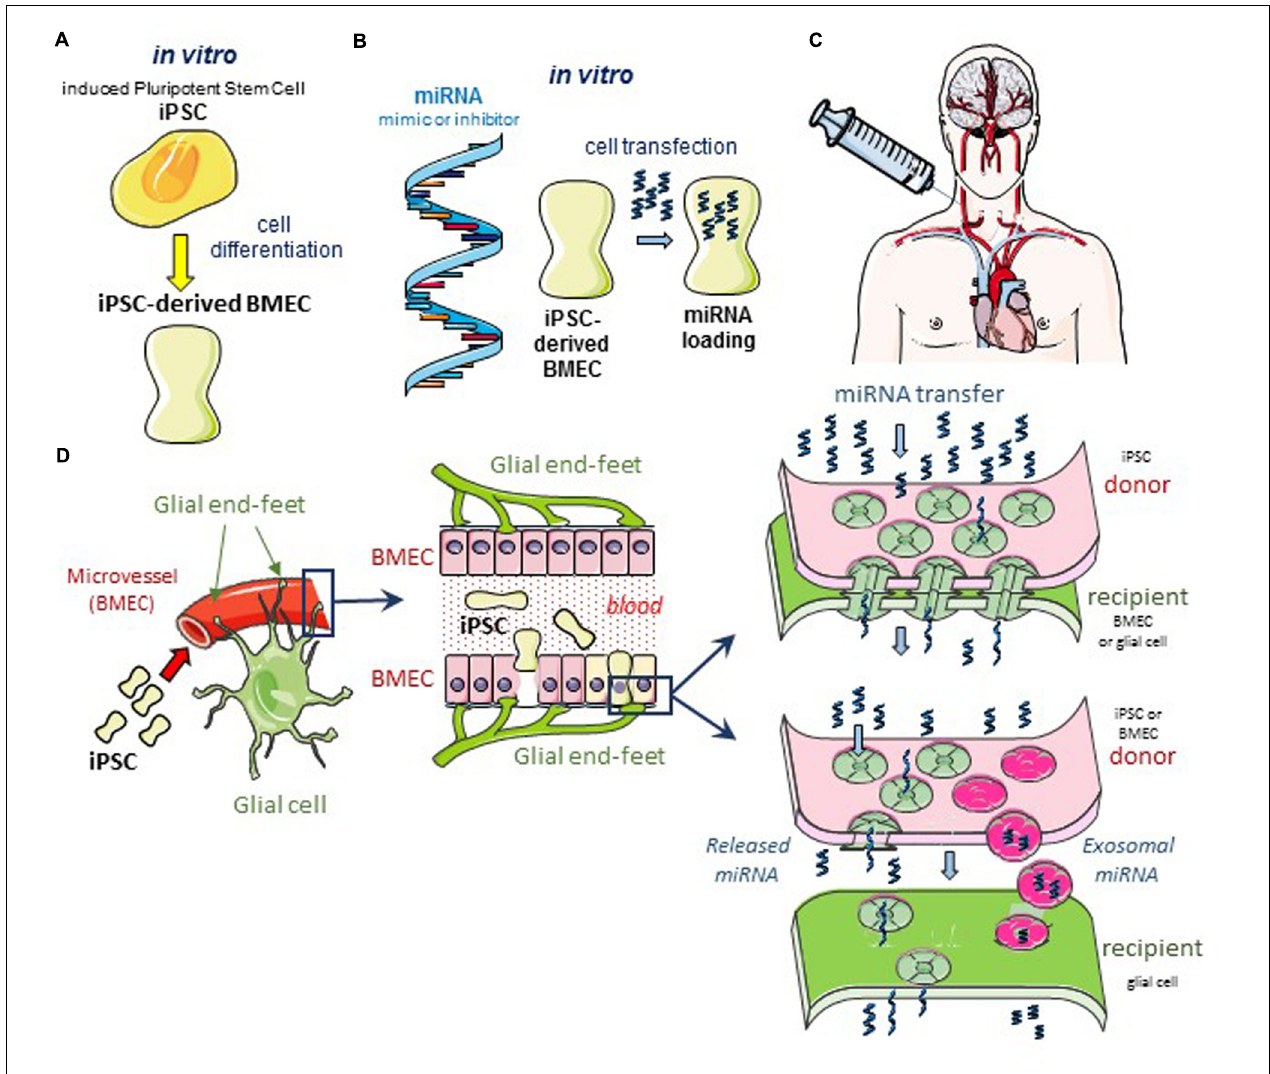
FIGURE 1 | Hypothetical cell based therapeutic intervention in glioblastoma. (A) Induced pluripotent stem cells (iPSC) of human origin (i.e., umbilical cord, bone marrow, biopsied tissue sample from diseased patient, or the immortalized cell line hBMEC/D3) are pre-differentiated with neural cells and retinoic acid in vitro (Lippmann et al., 2013, 2014a). After 2 days in co-culture, cells sorting with anti-von Willebrand Factor (vWF) antibody are iPSC-derived BMEC. These cells can be sub-cultured as a pure monolayer expressing typical endothelial and BBB markers. (B) In the following day, iPSC-derived BMEC are loaded with the microRNA (miRNA) of interest, using the lipofectamine transfection procedure as previously described (Thuringer et al., 2016a). (C) After 12 h in culture, transfected cells are dissociated and suspended in a conventional infusion medium then injected directly into the patient’s carotid artery. (D) Schematic diagrams of the GJ-mediated shuttling of microRNA at the microvascular level in situ . The blue box areas are enlarged in the scheme below. Note the expected diffusion of miRNA from the iPSC-derived BMEC (yellow) to a large number of cells (bystander effect). Two modes of miRNA transfer from BMEC to glioblastoma cells are proposed: direct via gap-junction channels (upper panel), and indirect via the release of miRNA either free or contained in exosomes, to the intercellular space (lower panel). In the two modes, the Cx43 expression is required at the plasma membrane of cells, forming gap junction or hemichannel (Soares et al., 2015; De Bock et al., 2017).